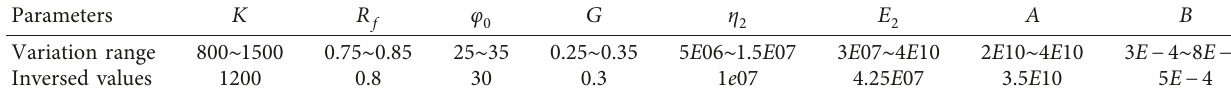
Table 4: Inversed values of coupled E- ν and Burgers model parameters.